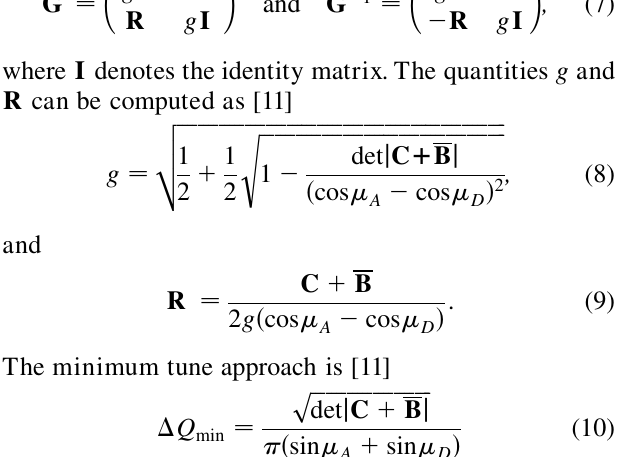
FIG. 1. Observation point at the beginning of an arc and beam trajectory in the